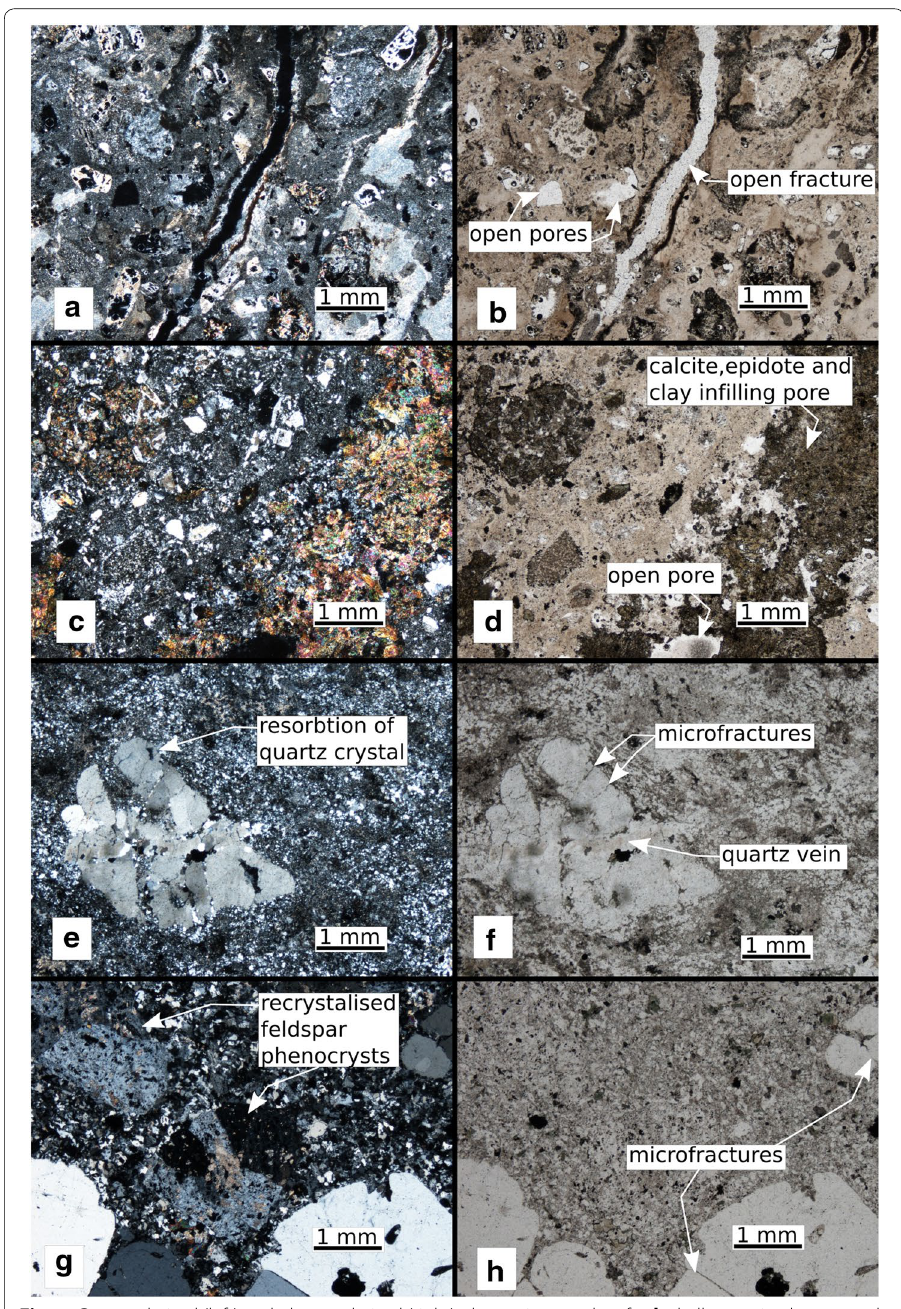
Fig. 5 Cross-polarised (left) and plane-polarised (right) photomicrographs of a , b shallow-, mixed pore-, and microfracture-dominated lapilli tuff with recrystallised pumice clasts, and partially precipitated microfrac- tures with altered margins (thin section from NM2_1350B_01 Wyering et al. 2014); c , d intermediate depth, pore-dominated lapilli tuff with large pores infilled with epidote and clay, most original textures are no longer visible due to re-crystallisation (thin section from NM11 1.2_01 Wyering et al. 2014); e , f deep, microfracture- dominated lapilli tuff showing recrystallization textures, quartz vein, and resorption of quartz crystal in pum- ice clast (thin section NM8A C1_4_02 from Wyering et al. 2014); g , h deep, microfracture-dominated tonalite with quartz and feldspar phenocrysts showing resorption (quartz) and recrystallization (feldspar) (thin section NM8A C2_1_1 from Wyering et al.